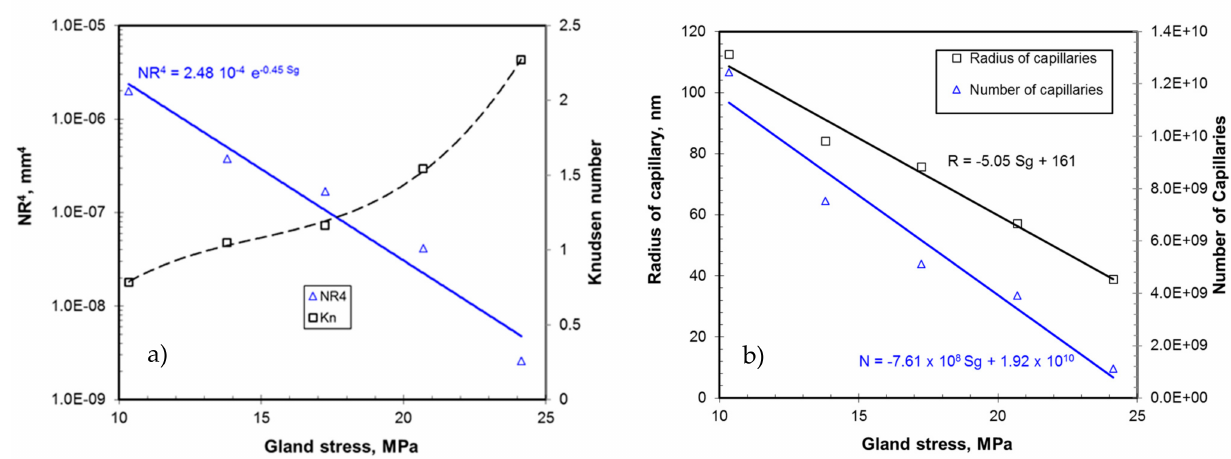
Figure 6. Variation of porosity parameters and Knudsen number for of Flexible graphite.